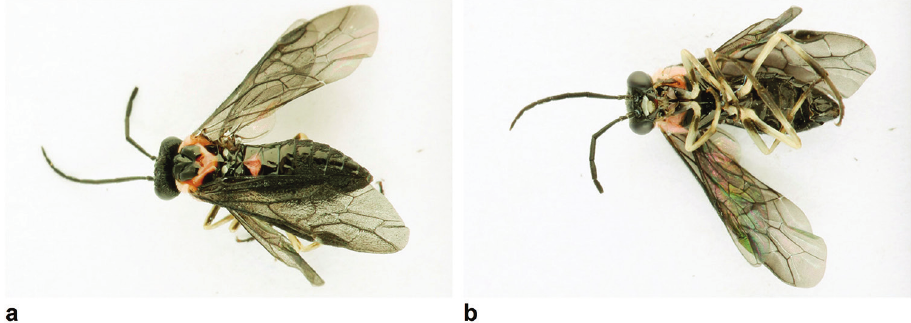
Figure 22. Stromboceros sutilis , female (P4239.G), body length 6.5 mm. a Dorsal view b ventral